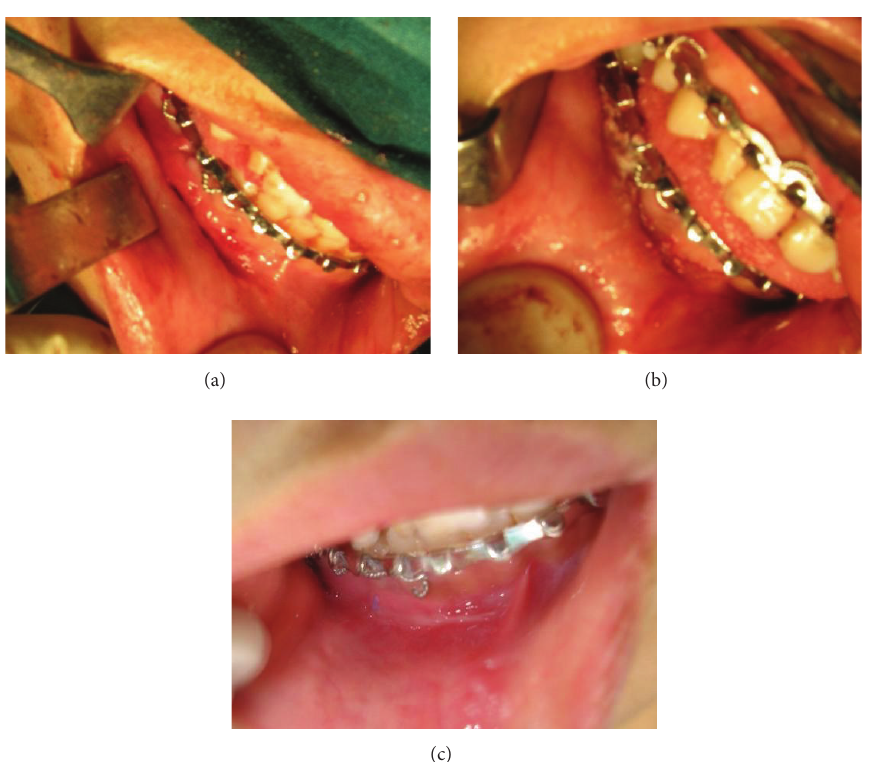
Figure 1: (a) Incision after submucosal closure. (b) Cyanoacrylate application over incision line. (c) Seventh postoperative